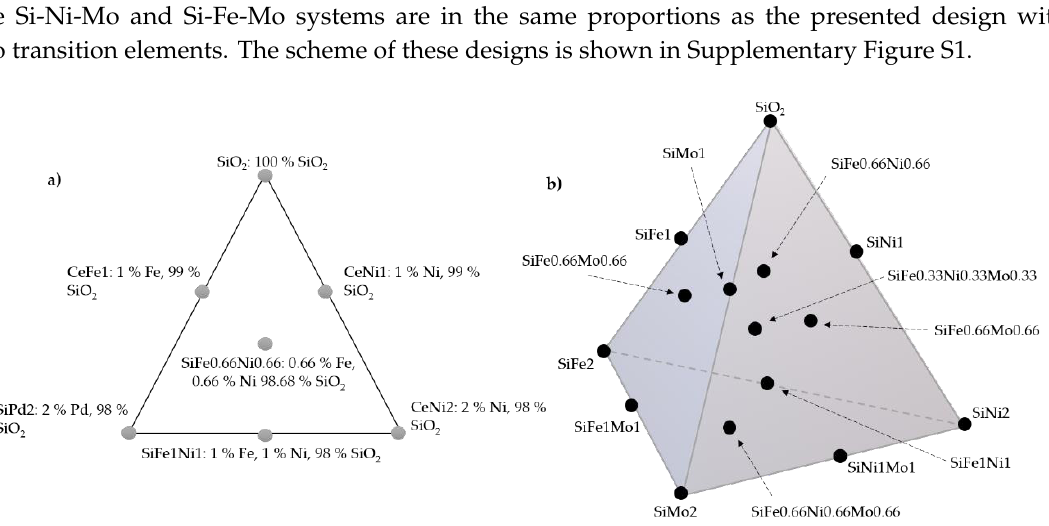
Figure 1. Simplex–centroid mixture design with ( a ) fumed silica (SiO 2 ), iron oxide (Fe 2 O 3 ), and nickel oxide (NiO); and ( b ) fumed silica (SiO 2 ), iron oxide (Fe 2 O 3 ), nickel oxide (NiO), and molybdenum oxide (MoO 3 ).